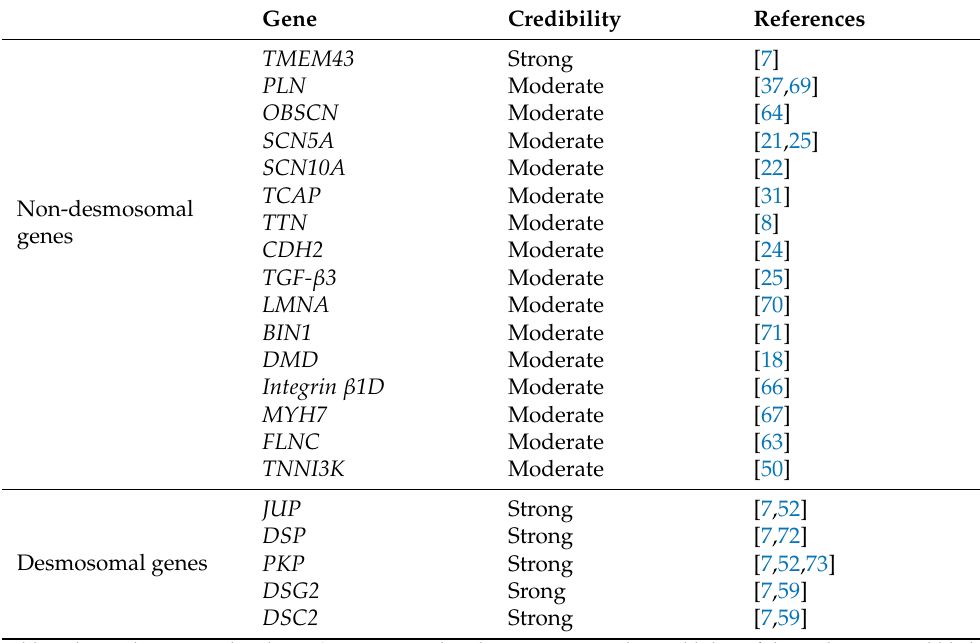
Table 1. Pathogenic and likely pathogenic (LP) genes related to ACM.